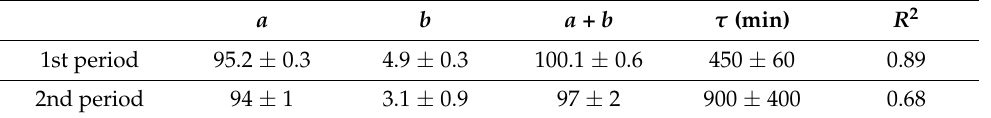
Figure 9. ( a ) Normalized output intensity (blue crosses) and temperature (green circles) of the LR-c3 fiber as a function of the sun-simulator exposition time. Red and black solid lines represent the fittings of Equation (2) to the intensity curves of both illumination periods. ( b ) Emission spectra of the sample at t = 0 and t = 16 h in the first excitation period. Table 3. Values obtained from the fittings to the first and to the second period of the experimental curve of Figure 9 with Equation (2). R 2 is the coefficient of determination of the